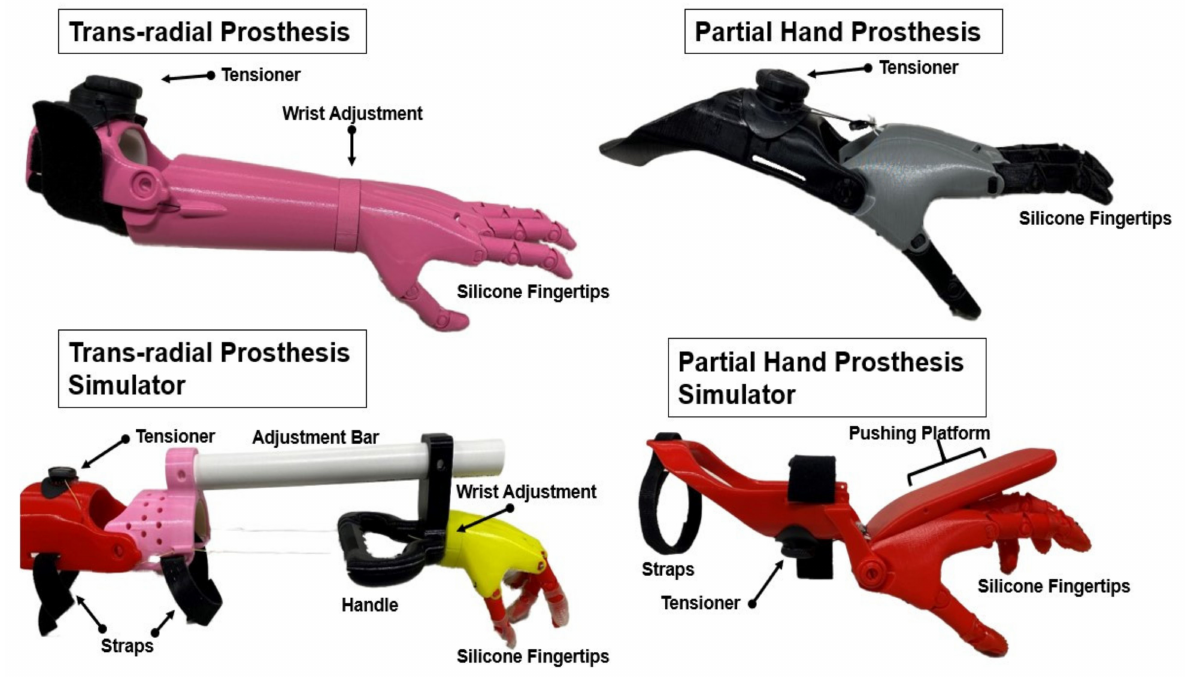
Figure 1. Description of prostheses and prosthetic simulators. The prosthetic simulators used in the study mimic the design and control mechanism of the prostheses. The partial hand prosthesis simulator allowed TD children to rest their existing hand on top of the simulator hand, with the wrist in slight extension. A pushing platform placed above the hand allowed active wrist flexion and passive extension to facilitate actuation of the hand. Similarly, the trans-radial simulators incorporated similar features to the trans-radial prosthesis, with the addition of a handle that allowed typically developed children to actuate the device by elbow